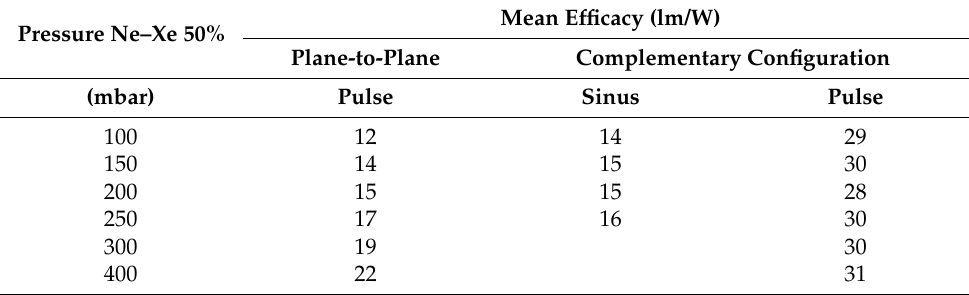
Table 1. Summary of the mean efficacy for alternate complementary coplanar configuration for several pressures and waveforms. The plane-to-plane geometry is retained as a reference. Based on the results presented in Figure 13, the standard deviation is